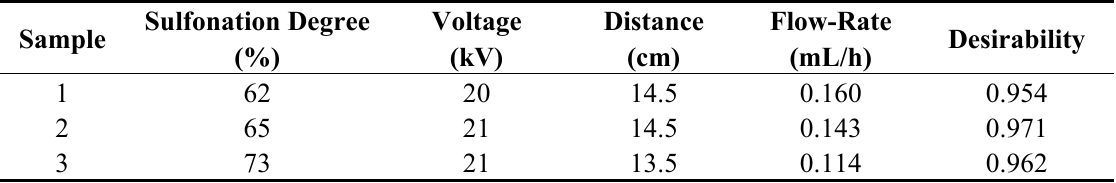
Table 8. Predicted optimized conditions and relative desirability function values for three samples at different sulfonation degrees.